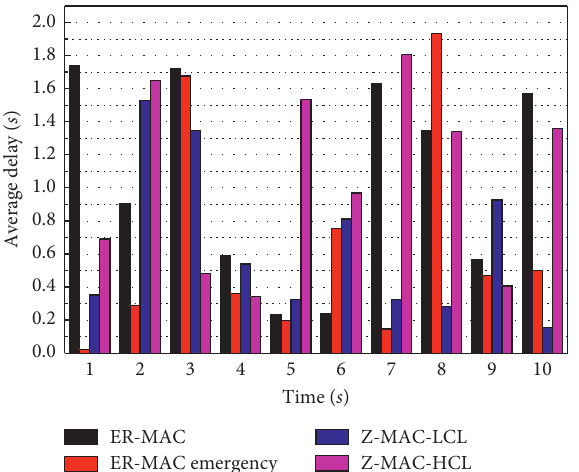
Figure 7: Comparison of the average latency of high-priority packets under different loads.